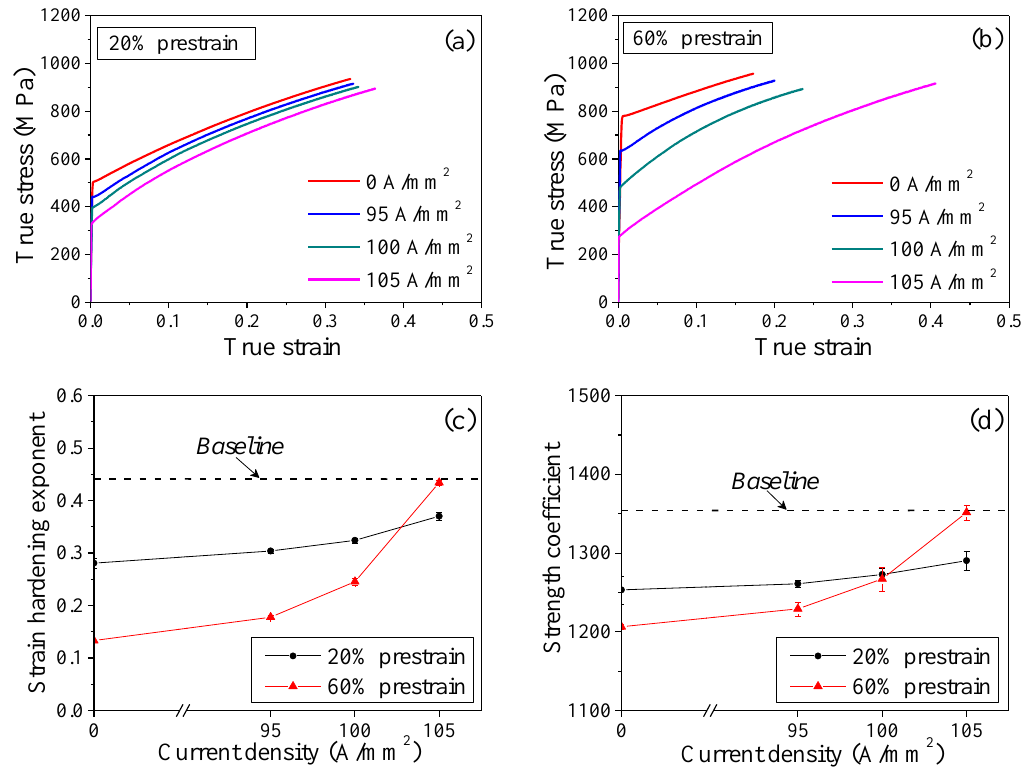
Figure 7. True stress-strain curves after EA annealing with ( a ) 20% prestrain and ( b ) 60% prestrain; ( c ) strain hardening exponent and ( d ) strength coefficient of prestrained specimens after EA annealing.